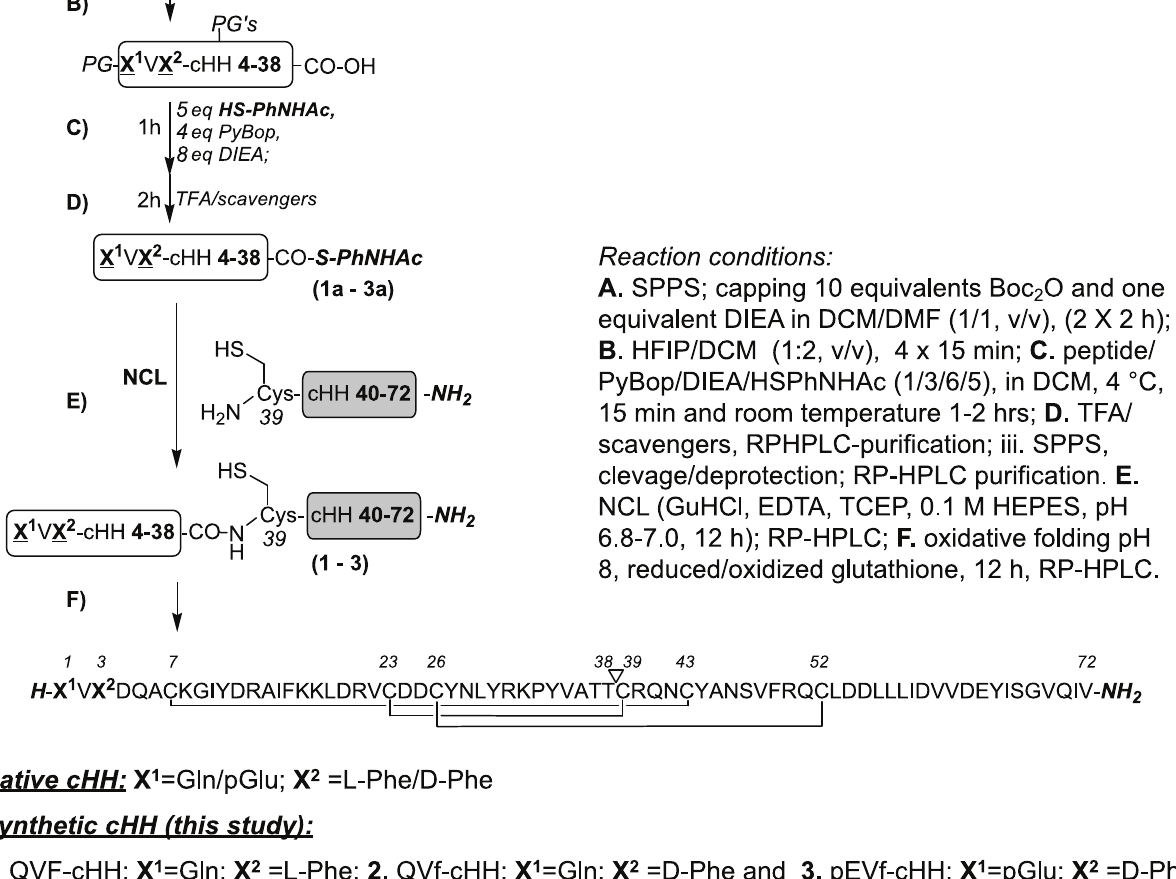
Figure 1. Scheme of the SPPS coupled to NCL to obtain the full length peptides. The leading segments containing a C-terminal thioester, QVF-cHH4-38, QVdF-cHH4-38, pEVdF-cHH4-38, and the cHH39-72 following segment with a free N-terminal cysteine were synthesized by SPPS. The NCL reaction between the leading and following segments returned the full length 72mer cHH isomers, which were further subjected to oxidative folding to obtain the folded peptides.